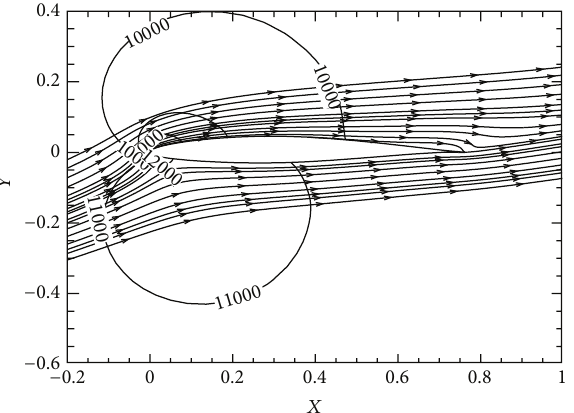
Figure 8: Pressure distribution and streamlines around the airfoil in the dry condition.